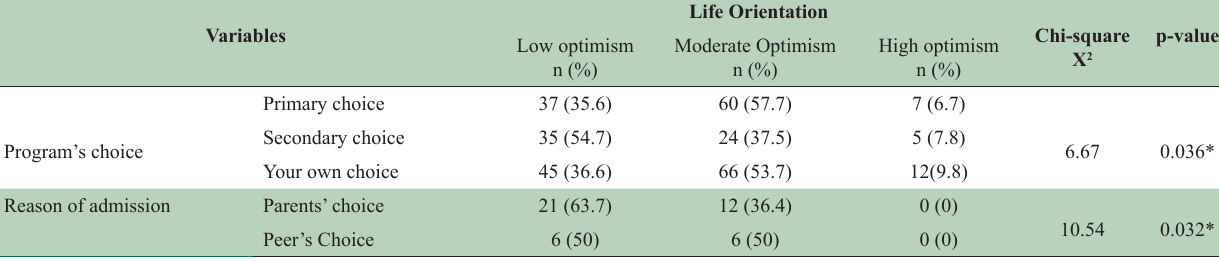
Table-IV: Association between life orientation (optimism) and some other variables among the